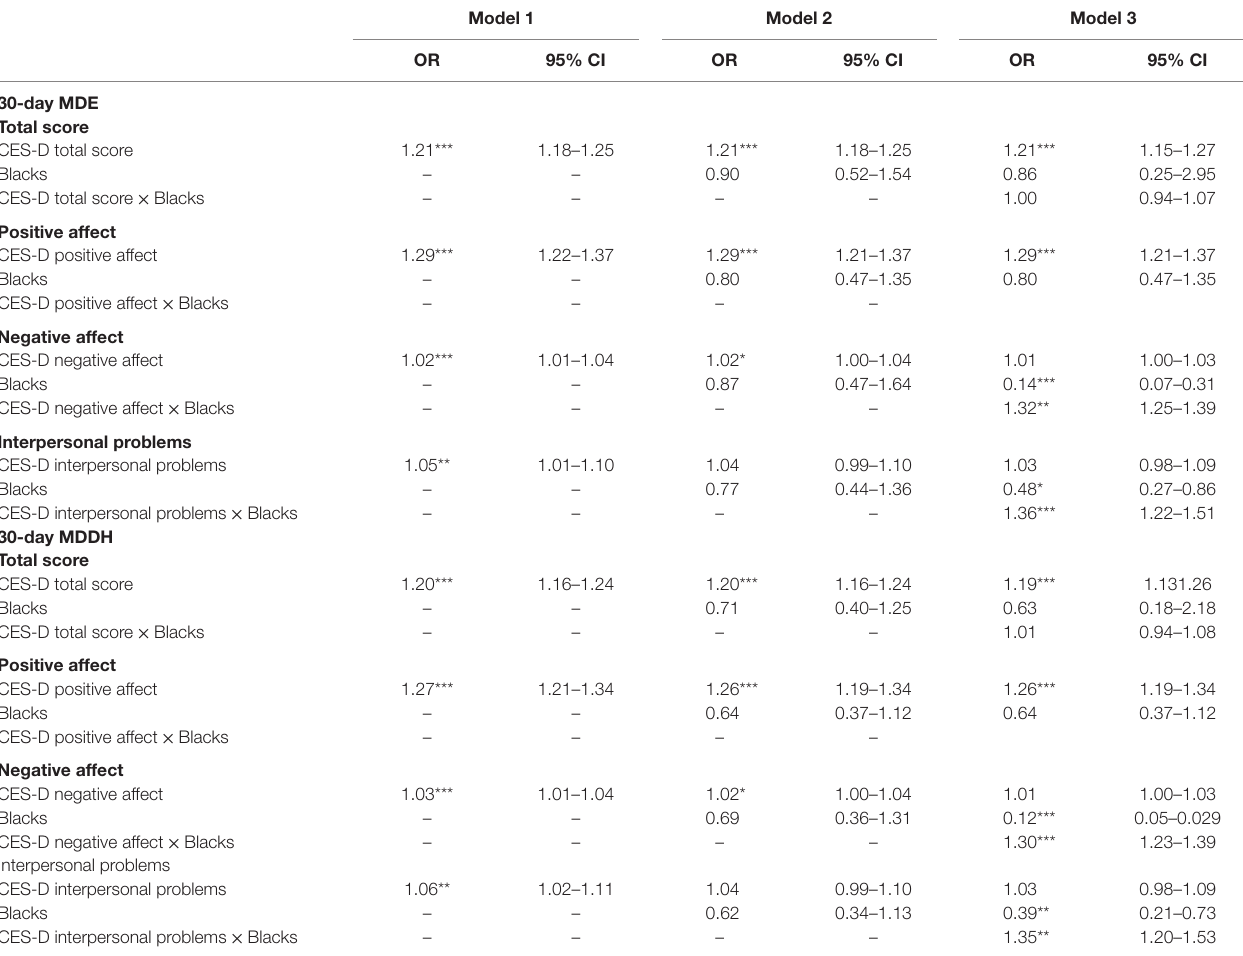
TaBle 5 | summary of regressions on the associations between ces-D factors and ethnicity on 30-day depressive disorders in the pooled